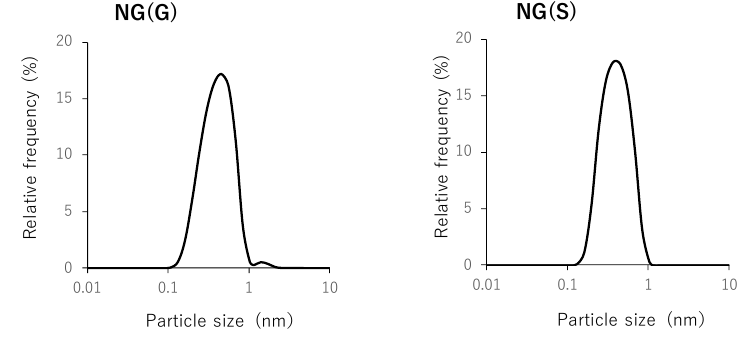
Figure 4. Size distribution of nanogels. Table 3. Particle size and ζ -potential of nanogels.